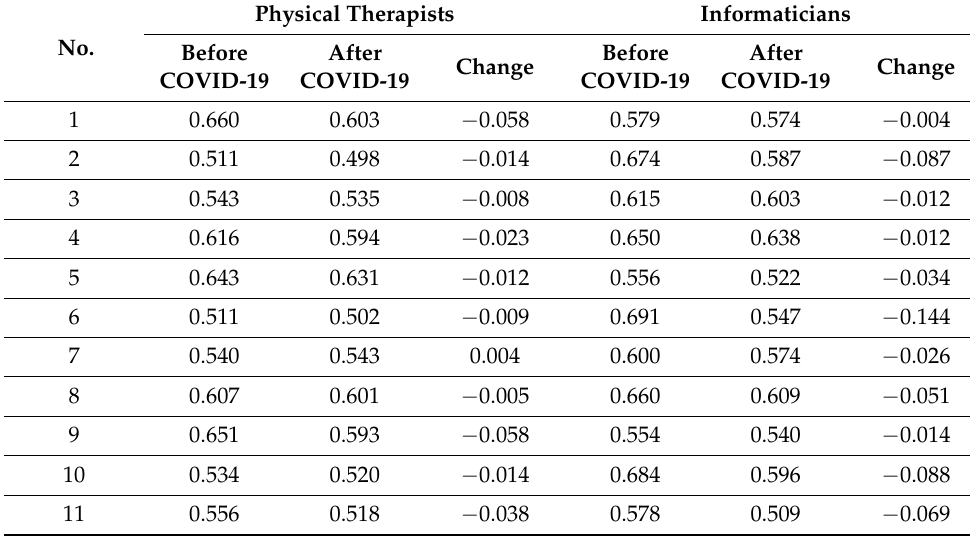
Table 7. Fuzzy models: Model 1, groups 1 and